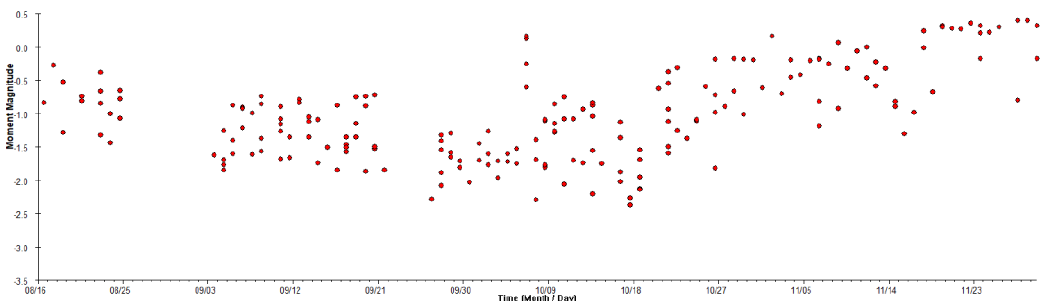
Figure 7. Temporal evolution of the moment magnitude of MS events.